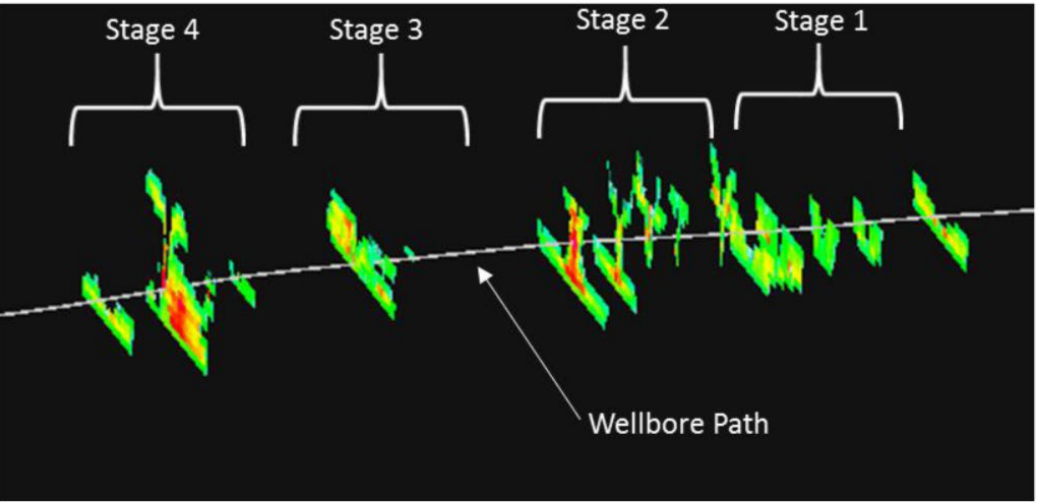
Figure 10. Three-dimensional depiction of the first four fracturing stages (heel to left, toe to right)